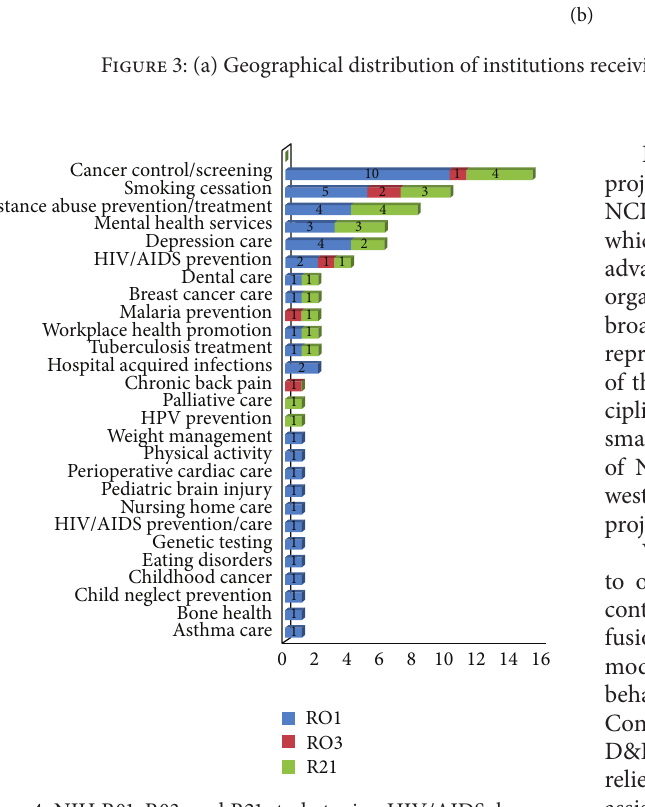
Figure 4: NIH R01, R03, and R21 study topics. HIV/AIDS: human immunodeficiency virus/acquired immunodeficiency syndrome; HPV: human papilloma